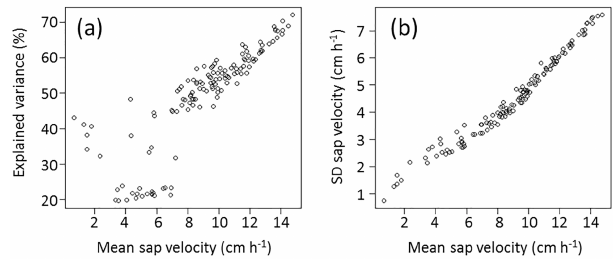
Figure 7. (a) Explained variance of the linear models in relation to mean sap velocities for all 132 days of the study period and (b) stan- dard deviation of sap velocity depending on mean sap velocities for those 132